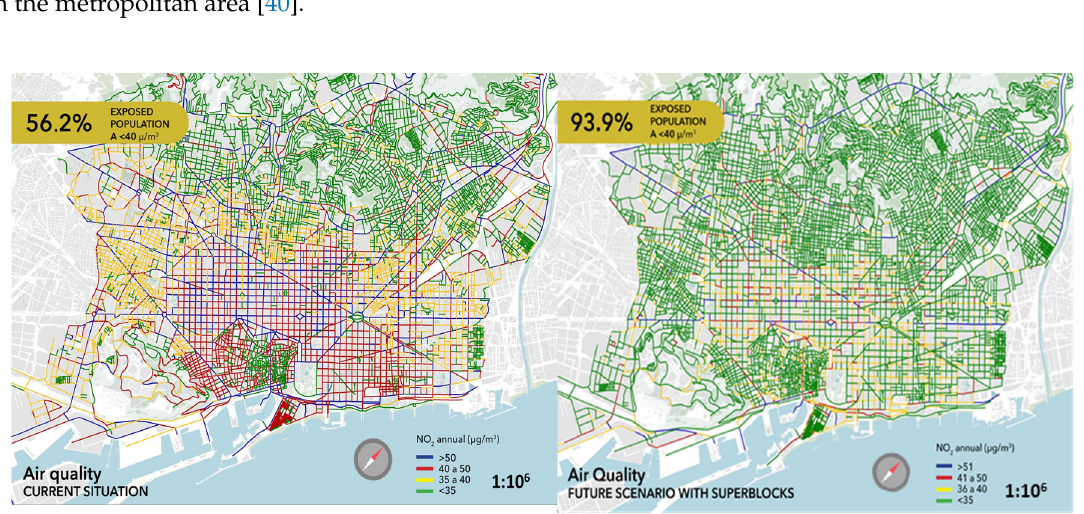
Figure 5. Population exposed to air quality, current situation and future scenario with Superblocks. Barcelona. Source: Reproduced from [25].